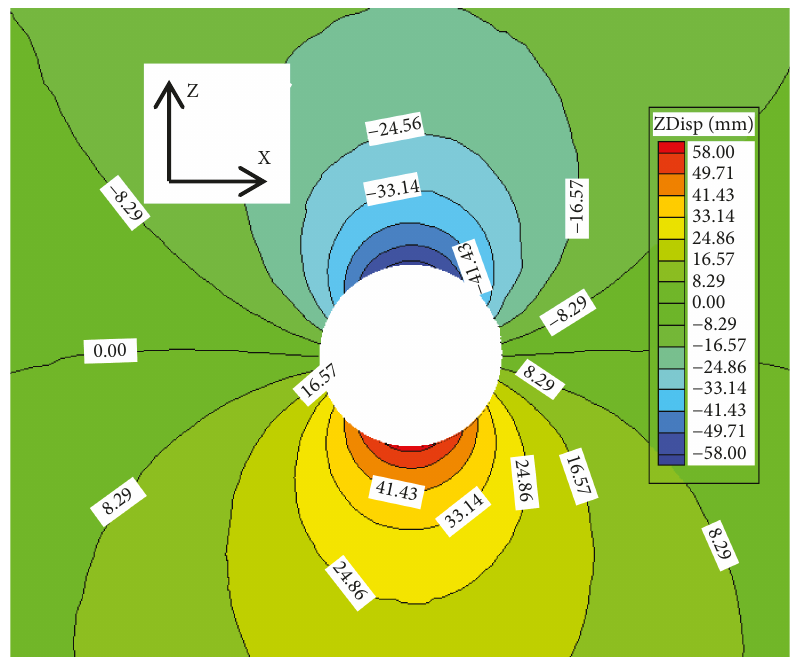
Figure 23: Displacement of section C-C along